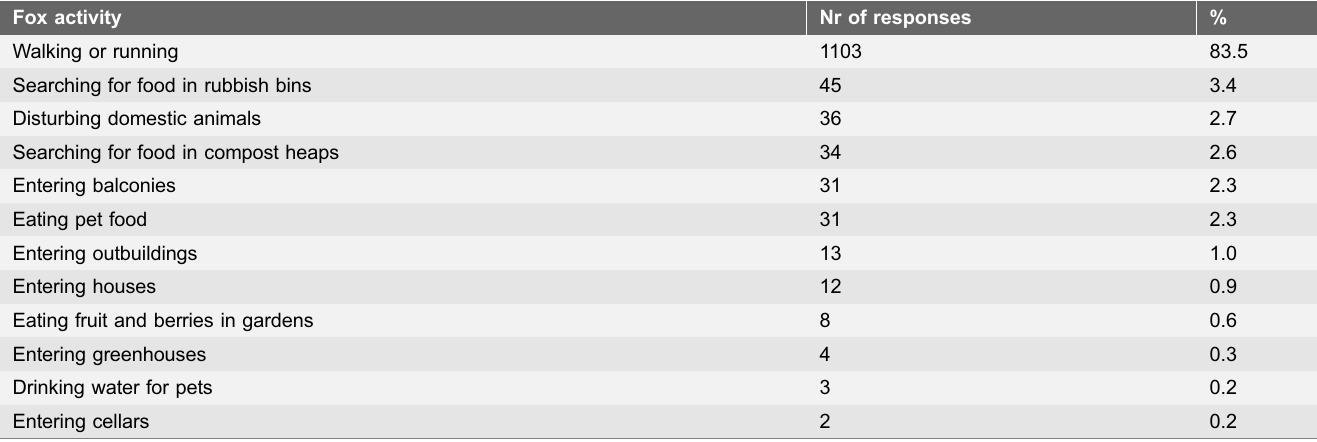
Table 1. Red fox activities in Estonian urban areas.